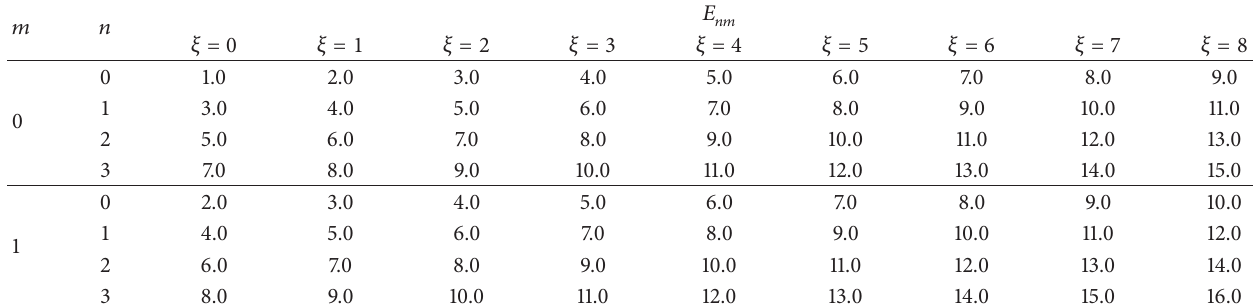
Table 4: The nonrelativistic energy eigenvalues ( 𝐸 𝑛𝑚 in atomic units) of the harmonic oscillator potential for various 𝜉 values and 𝜔 𝐿 = 0